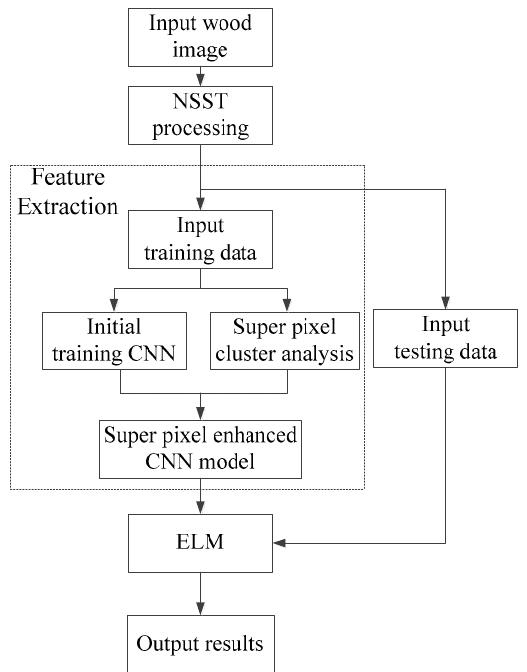
Figure 7. Flowchart of wood defect feature extraction and classification process.